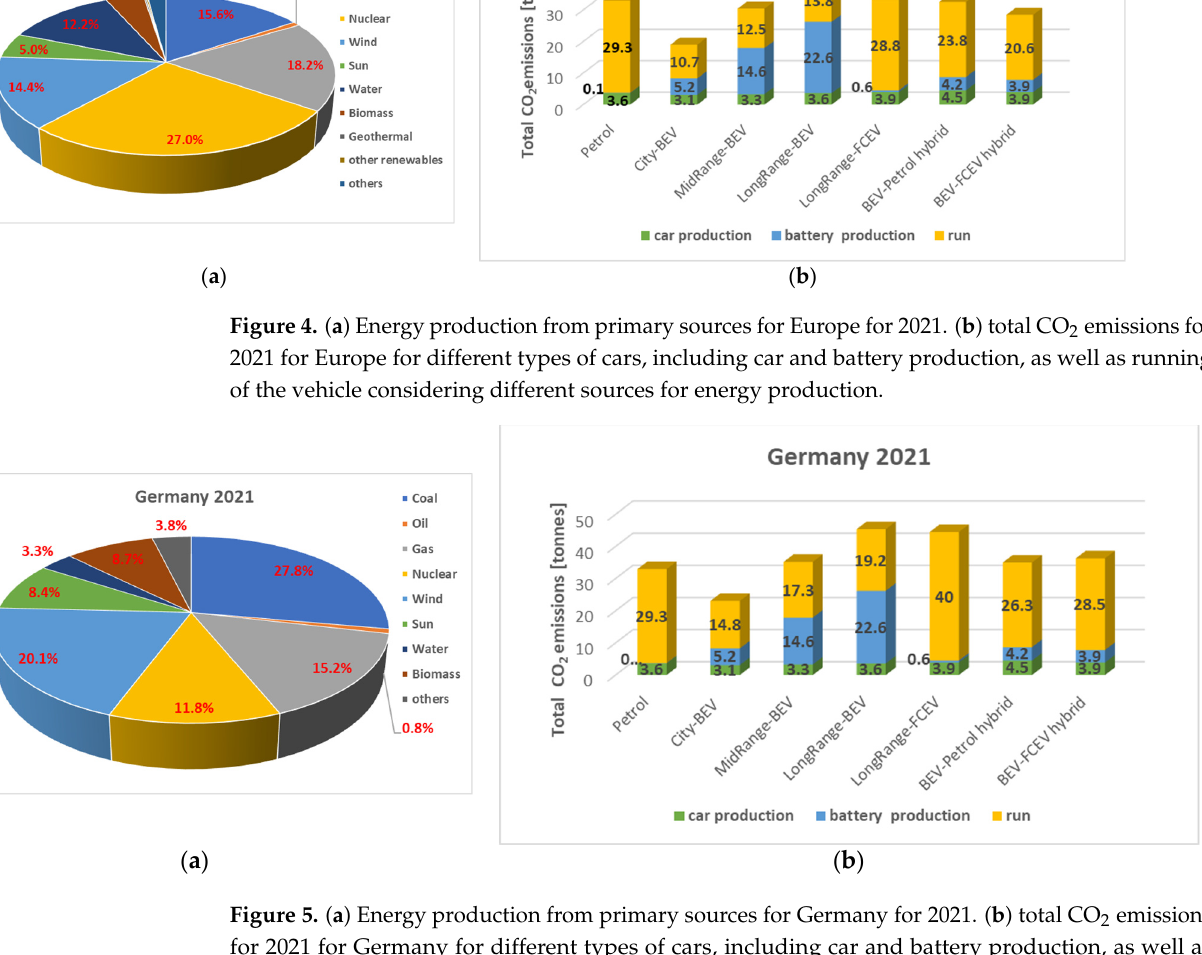
Figure 5. ( a ) Energy production from primary sources for Germany for 2021. ( b ) total CO 2 emissions for 2021 for Germany for different types of cars, including car and battery production, as well as running of the vehicle considering different sources for energy